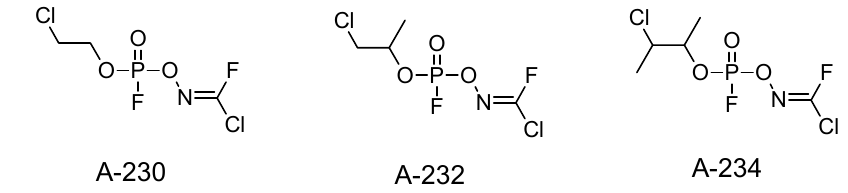
Figure 3. Possible A-series nerve agents, as reported by Hoenig [12].